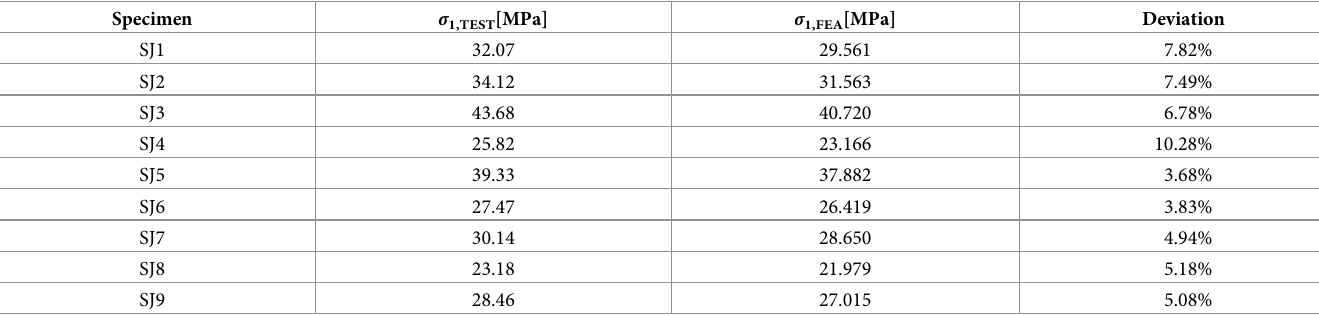
Table 5. Comparison of central stress of the surface U-2 between simulation and test results.